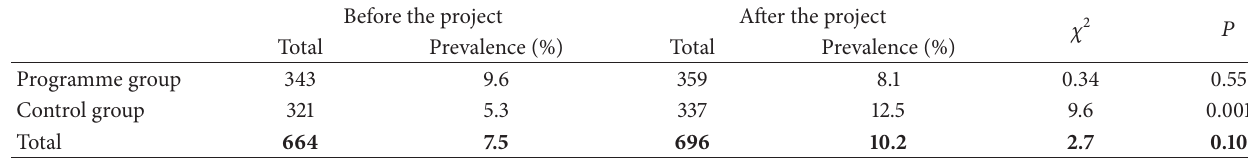
Table 4: Comparison of intestinal parasite carriage rates (%) before and after the project. Before the project After the